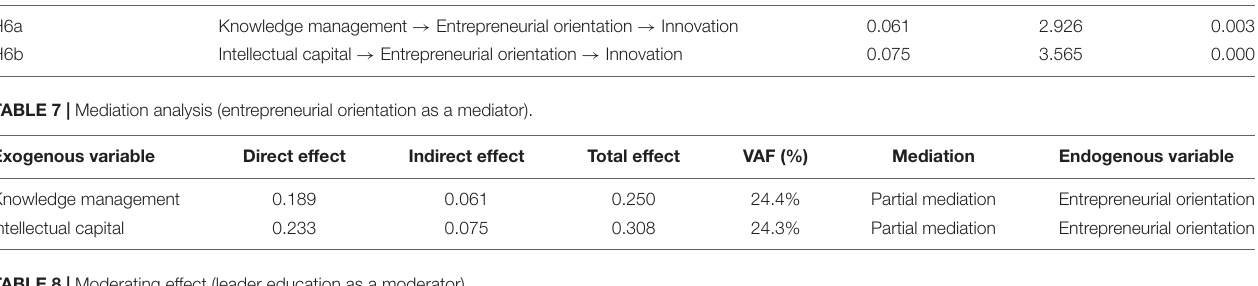
TABLE 8 | Moderating effect (leader education as a